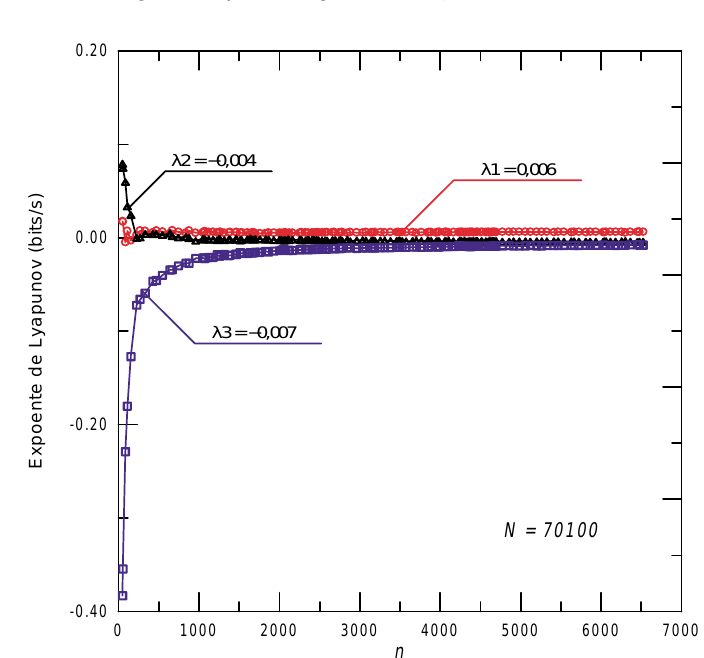
Fig. 11. Noisy chaotic signal. (a) Kantz; (b)Rosenstein et al.